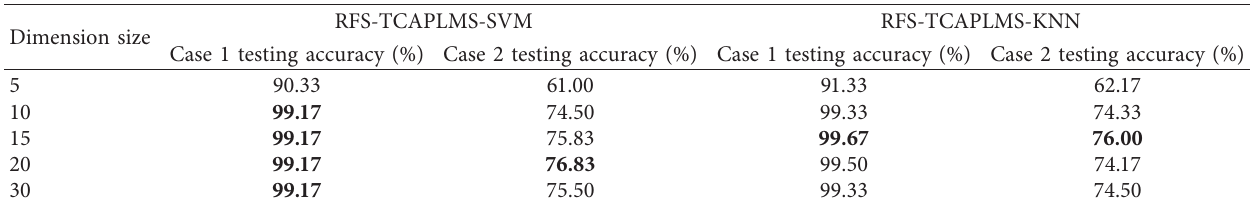
Table 15: The testing accuracies of the RFS-TCAPLMS-SVM and RFS-TCAPLMS-KNN. RFS-TCAPLMS-SVM RFS-TCAPLMS-KNN Dimension size